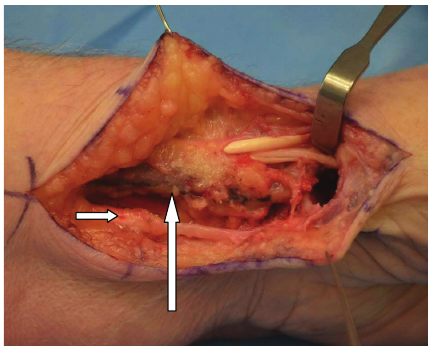
Figure 1: Radial artery marked by vertical arrow and FCR not visible as expected ulnar to the radial artery. Palmaris Longus seen inferiorly by horizontal arrow in the photo and APL and EPB superiorly.